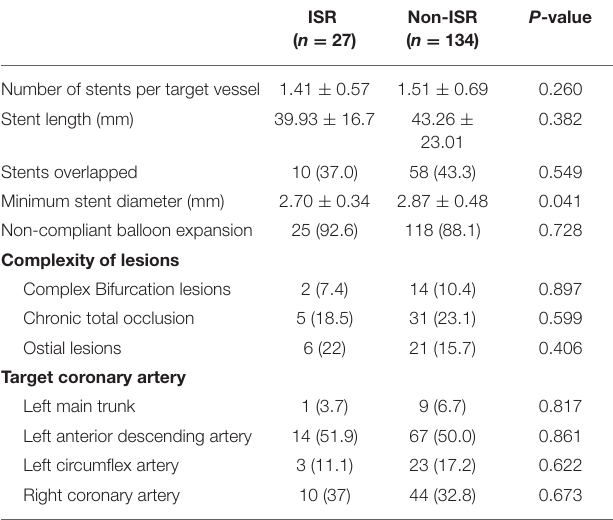
P -value ISR Non-ISR ( n = 27) ( n = 134)